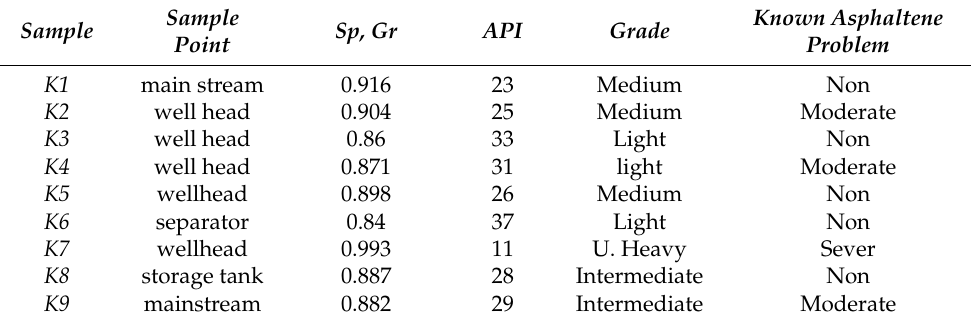
Table 2. Crude samples.